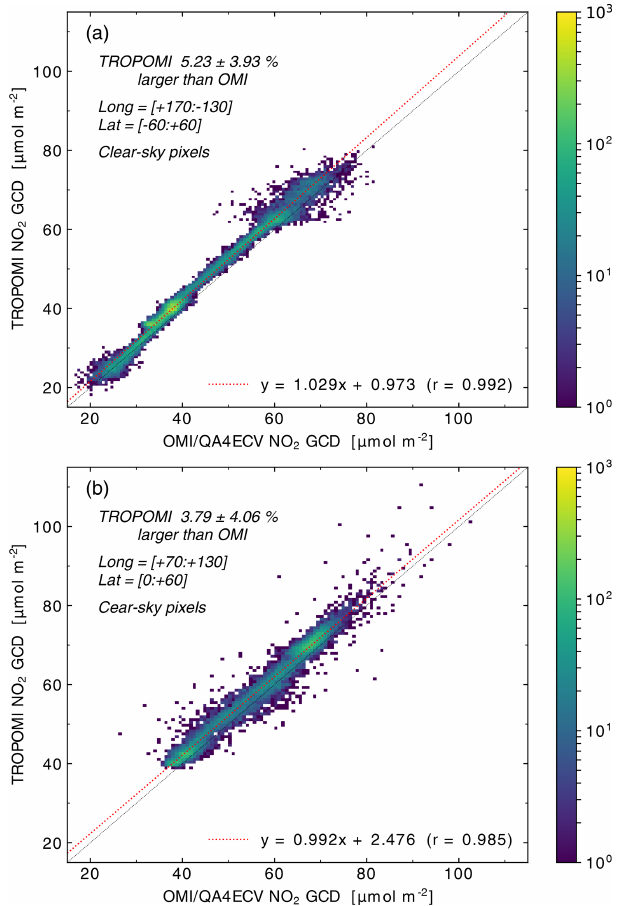
Figure 6. Comparison of TROPOMI and OMI–QA4ECV NO 2 GCD for clear-sky ground pixels for July 2018 after conversion to a common longitude–latitude grid of 0 . 8 ◦ × 0 . 4 ◦ for (a) the Pacific Ocean and (b) the India-to-China area. The area covered, the differ- ence between TROPOMI and OMI–QA4ECV, the linear fit coeffi- cients, and the correlation coefficient are listed in the